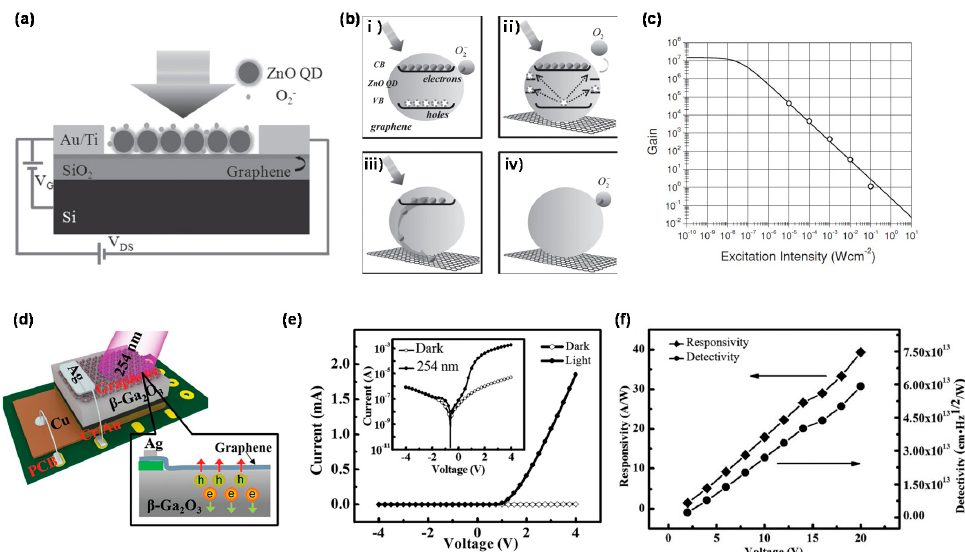
Figure 5. ( a ) Schematics of the graphene device coated with ZnO QDs; ( b ) The mechanism of the oxygen-assisted charge transfer process. (i) With irradiation of photon energy larger than the bandgap of the QDs, electron-hole pairs are generated; (ii) The holes are trapped at the surface states, leaving behind the unpaired electrons. The trapped holes will discharge the oxygen ions on the surface, and the oxygen molecules are desorbed; (iii) The electrons will transfer from the QDs to the graphene layer; (iv) With laser turned off, no more electron-hole pairs are generated. The oxygen molecules will re-adsorb on QDs and capture the remaining electrons to form oxygen ions on the surface; ( c ) Gain as a function of excitation intensity. Reproduced with permission for Figure 5a–c from 2013 Small [49]; ( d ) Schematic diagram of the MLG/ β -Ga 2 O 3 PD; ( e ) Current-voltage characteristics of the device under dark and 254 nm-light irradiation. The inset shows the current-voltage curves on a logarithmic scale ( f ) Responsivity and detectivity of the multi-layer graphene-Ga 2 O 3 heterojunction PD as a function of different bias voltages. Reproduced with permission for Figure 5d–f from 2016 Advanced Materials